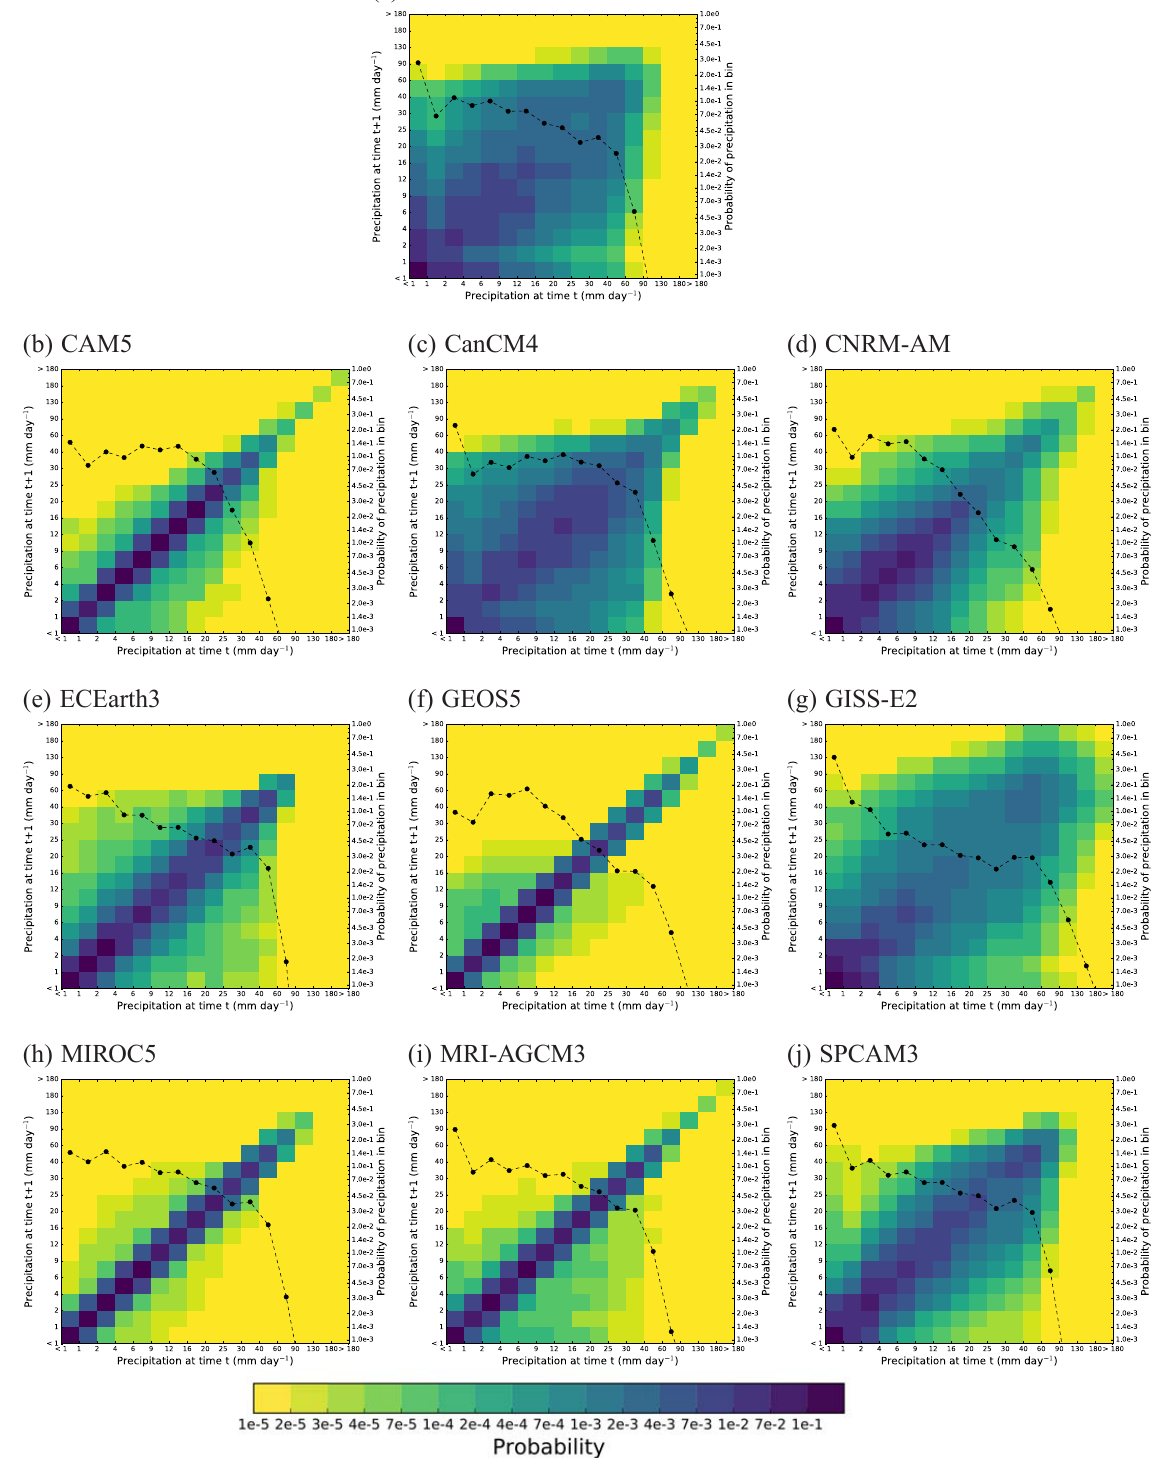
Figure 12. As in Fig. 4, but using time step rain rates that were first spatially averaged to a 5.6 ◦ × 5 . 6 ◦ horizontal